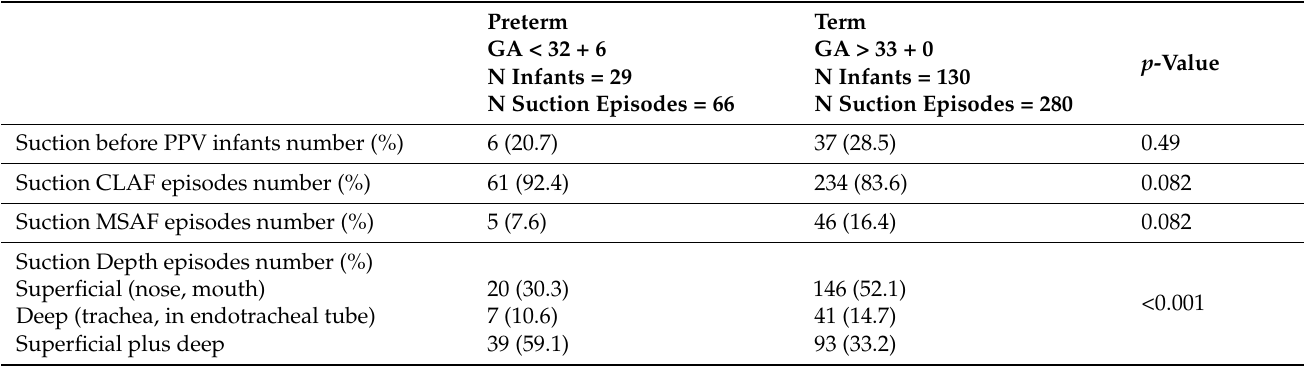
Table 2. Characteristics of suction episodes in 159 preterm and late preterm/term infants who received airway suctioning and positive pressure ventilation.